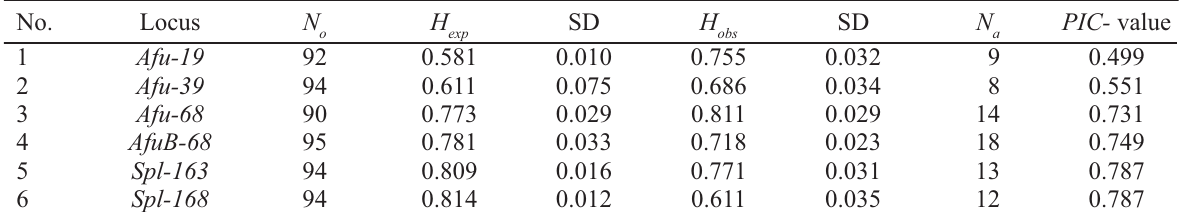
Expected heterozygosity ( H exp ), observed heterozygosity ( H obs ), numer of alleles (N a